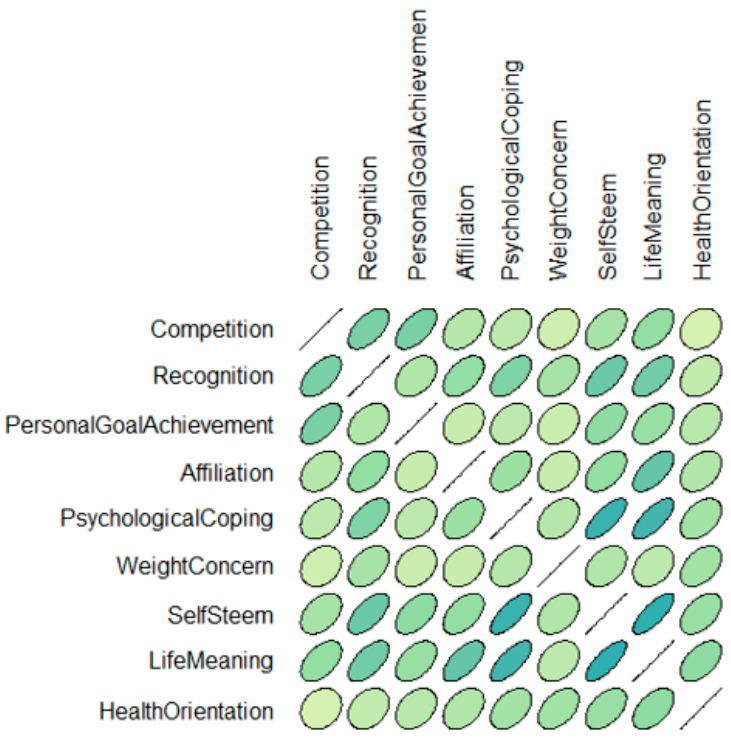
Figure A1. Cronbach’s alpha. Source: developed by the authors.